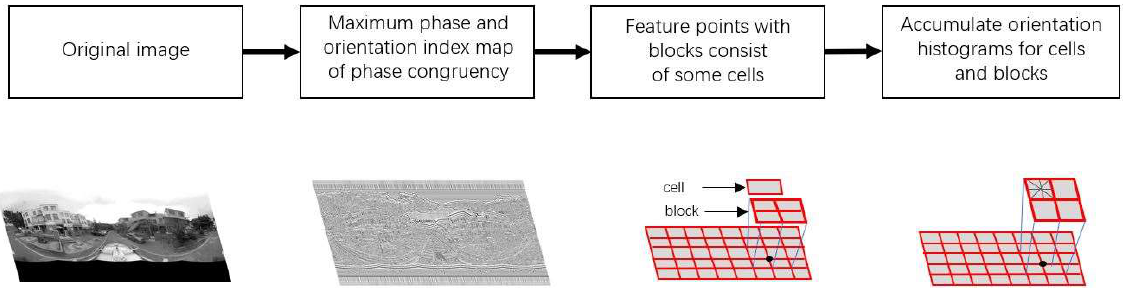
Figure 5. The main processing chain of the HGIFP descriptor.